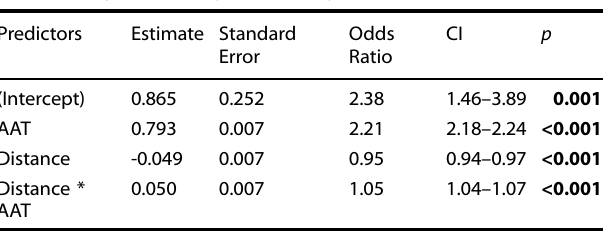
Table 1. Regression analyses for Study 1. Table 2. Regression analyses for Study